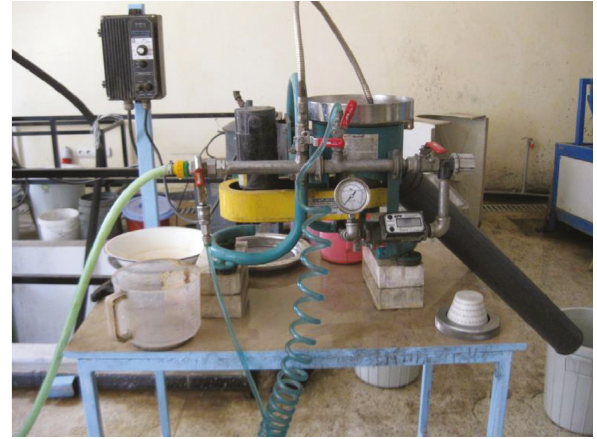
Figure 4: Experimental KC-MD3 model laboratory-type Knelson gravity